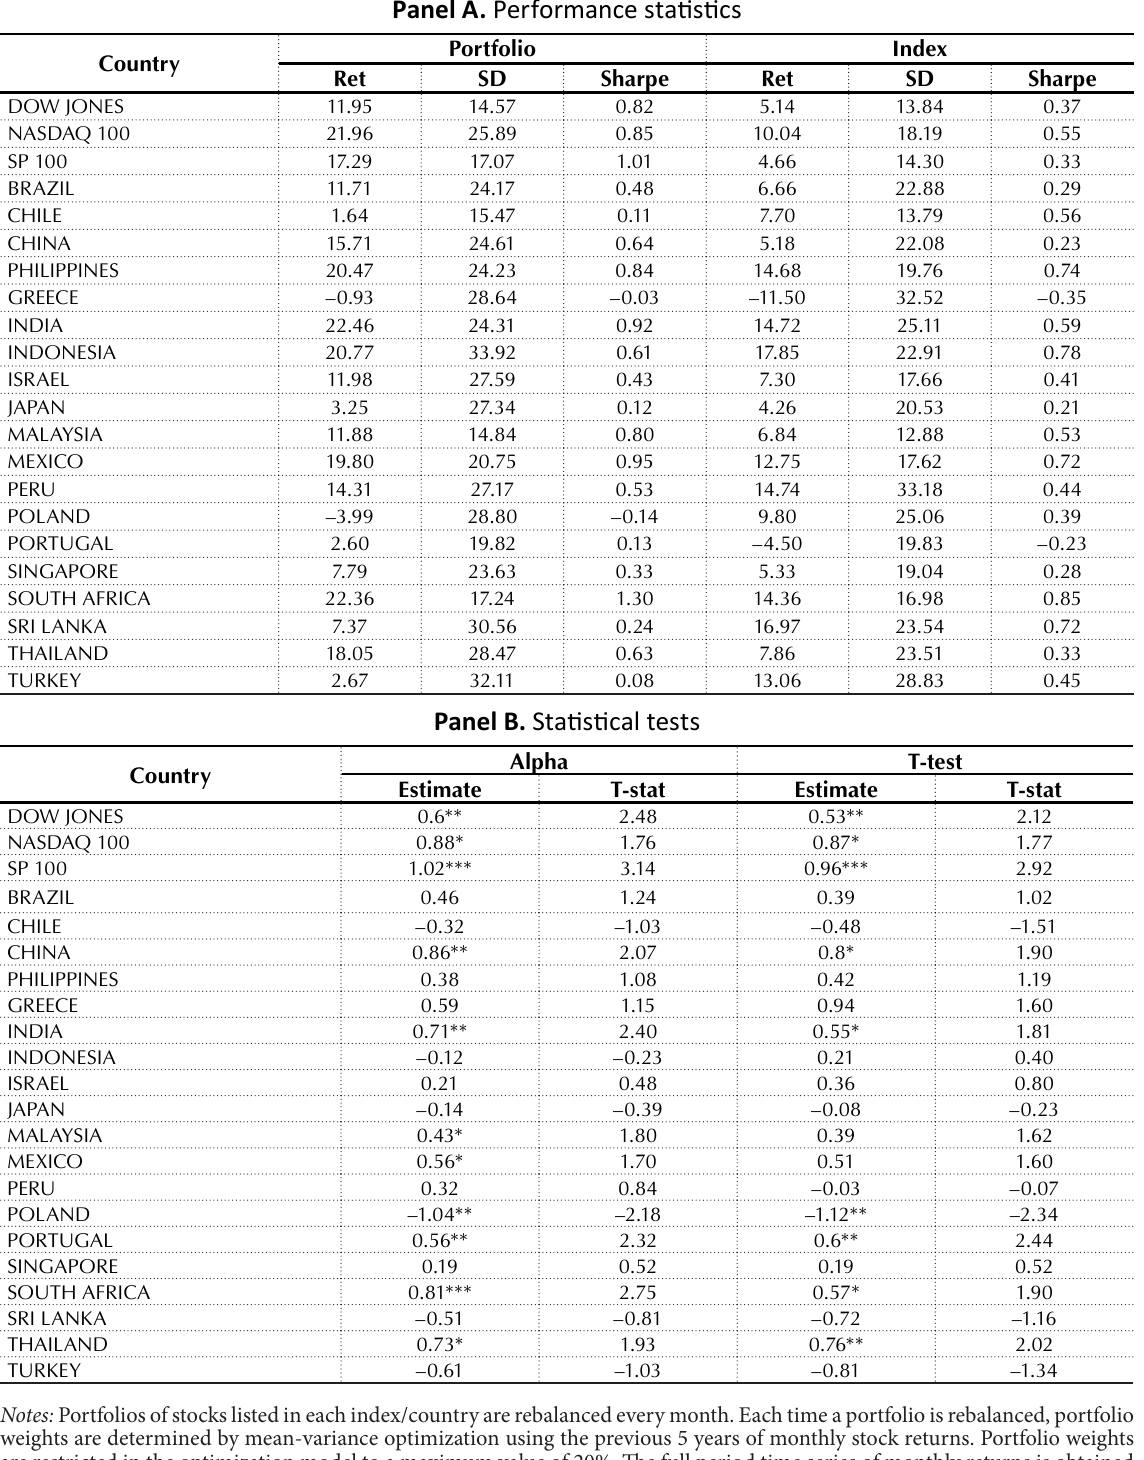
Table 6. Performance of restricted mean-variance optimized portfolios Panel A. Performance